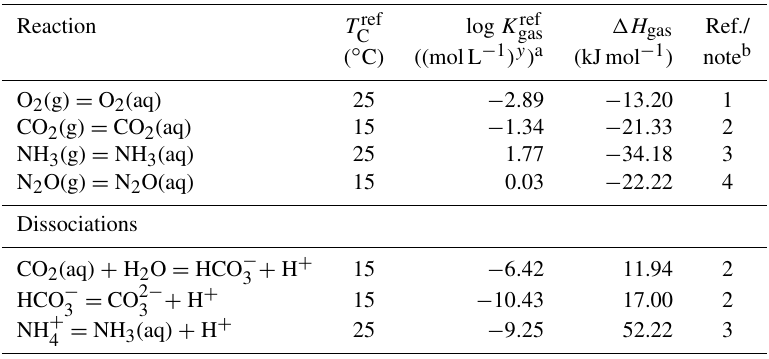
log K ref gas (cid:49)H gas Ref./ C ( ◦ C) ((molL − 1 ) y )